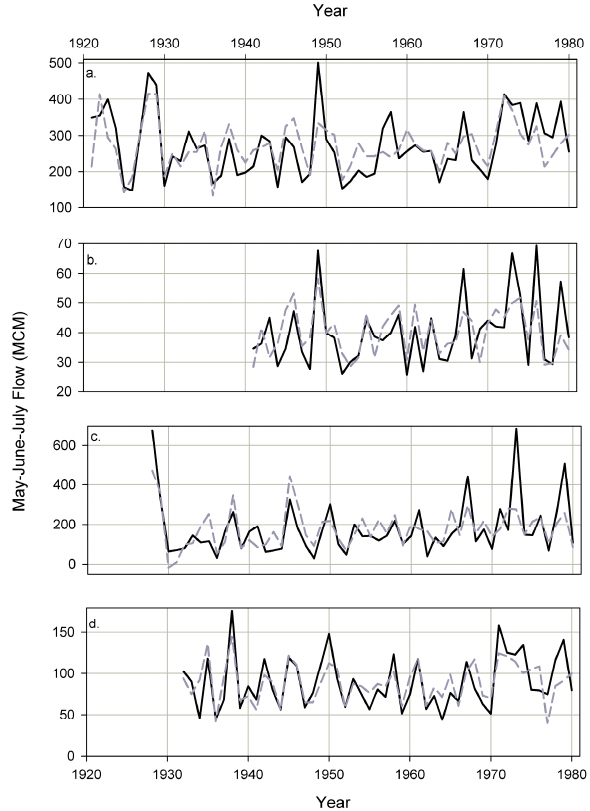
Figure 3. May–June–July streamflow calibration models for ( a ) Nolichucky River (1921–1980), ( b ) Nantahala River (1941–1980), ( c ) Emory River (1928–1980), and ( d ) SF Holston (1932–1980). Observed (dark, solid line), reconstructed (gray, dashed line).